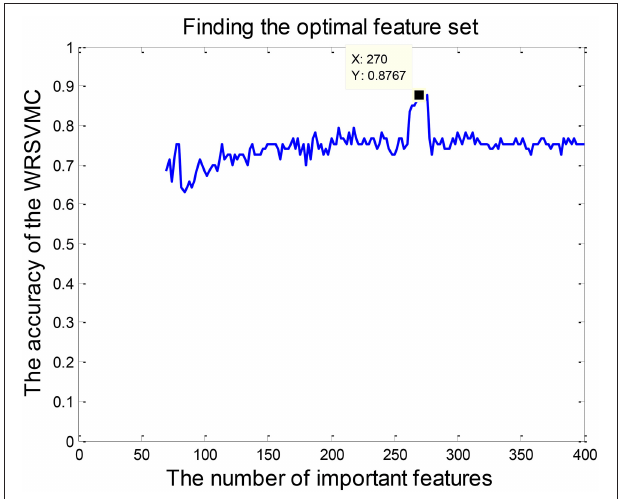
FIGURE 7 | The frequency of each brain